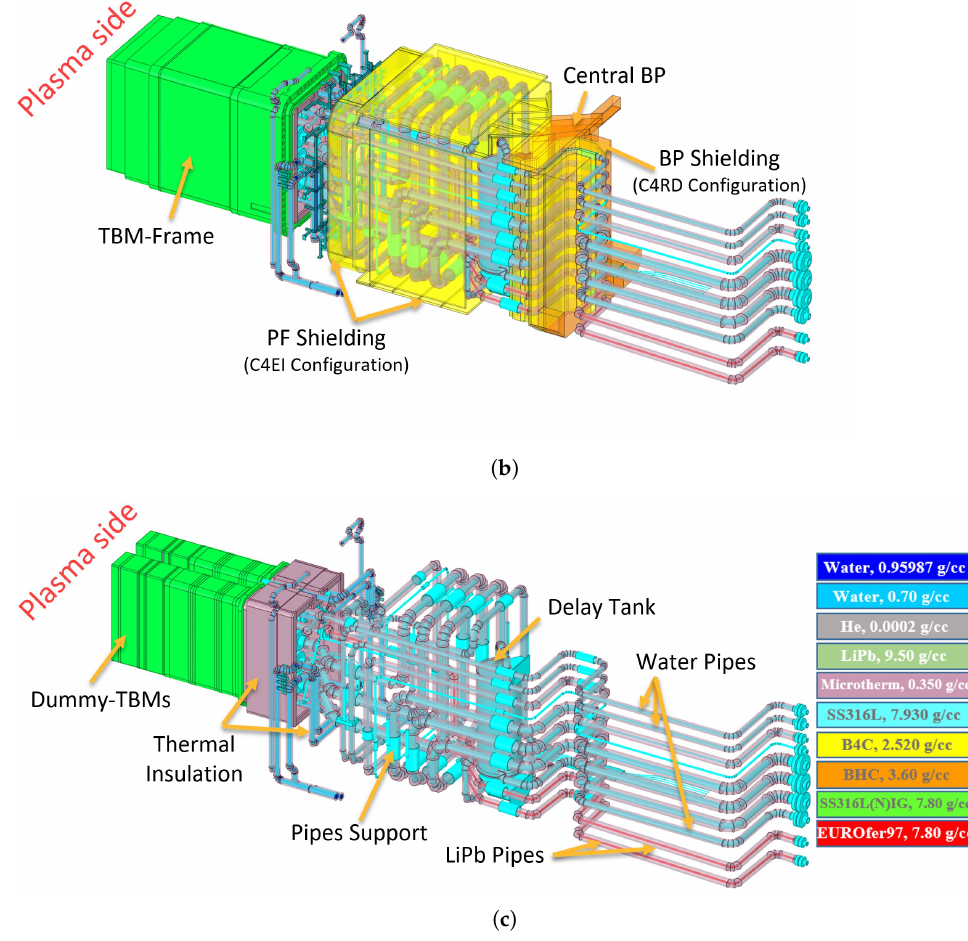
Figure 3. ( a ) CAD Model of the TBM-PP and PF with exposed internals in ( b , c